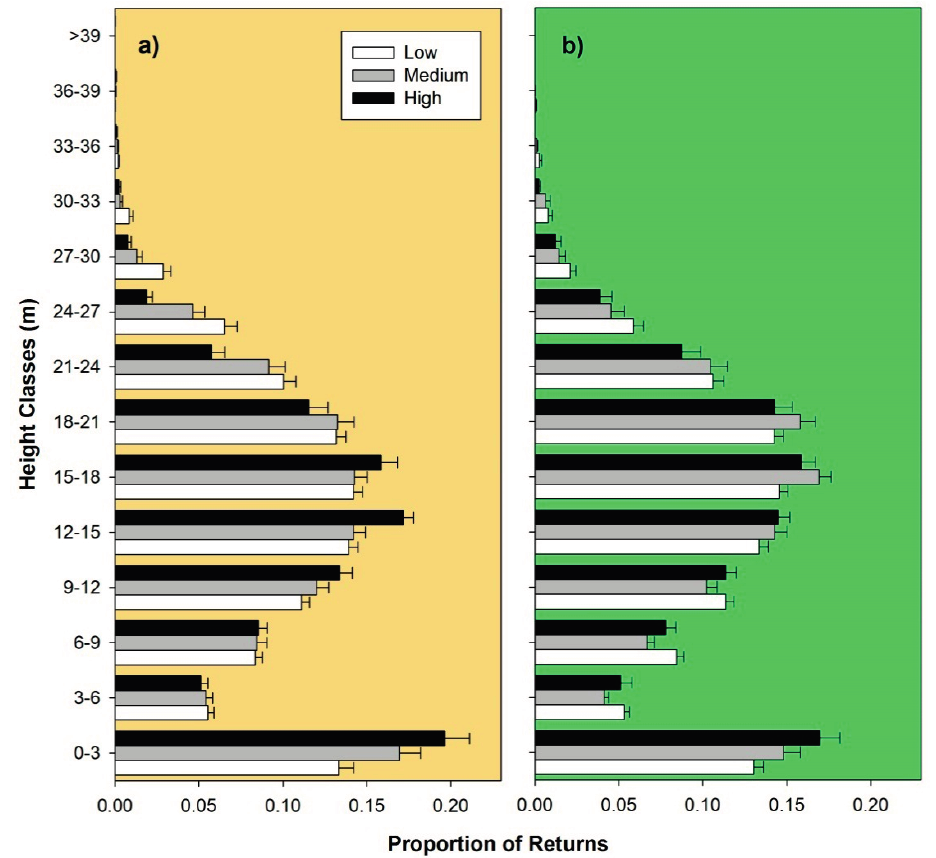
Figure 6. Histograms for average proportion of LiDAR point returns binned by 3-m height classes for ( a ) non-terraced and ( b ) terraced plots divided into low (0°–10°), medium (10°–20°), and high (>20°) sloped